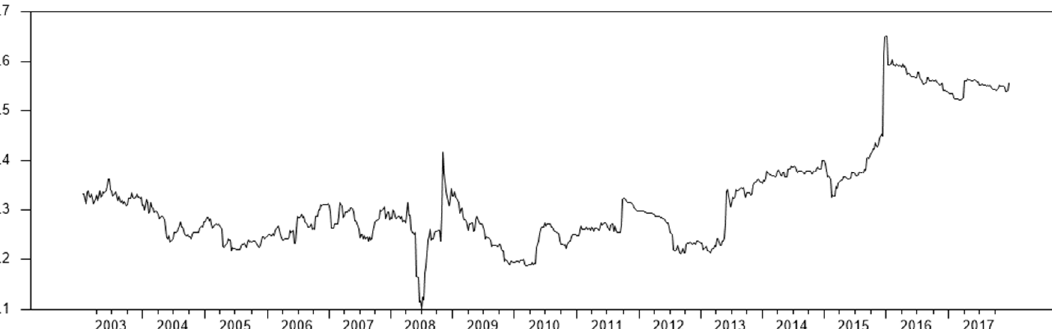
Figure 4. Dynamic correlation between the South African bond market and U.S.-funded carry trade returns.